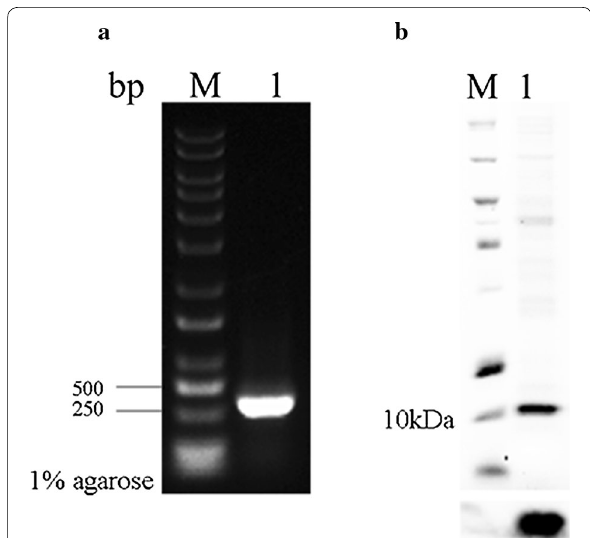
Fig. 7 Gene cloning and purification of TK-cystatin. a PCR products were amplified from the genome of T. kitauei . Line M: DNA marker (M115, GenStar); Line 1: TK-cystatin gene. b Purified TK-cystatin was analyzed by 12% SDS-PAGE (up) and western blotting (down), Line M: Protein marker (26630, Thermo Scientific); Line 1: purified TK-cystatin